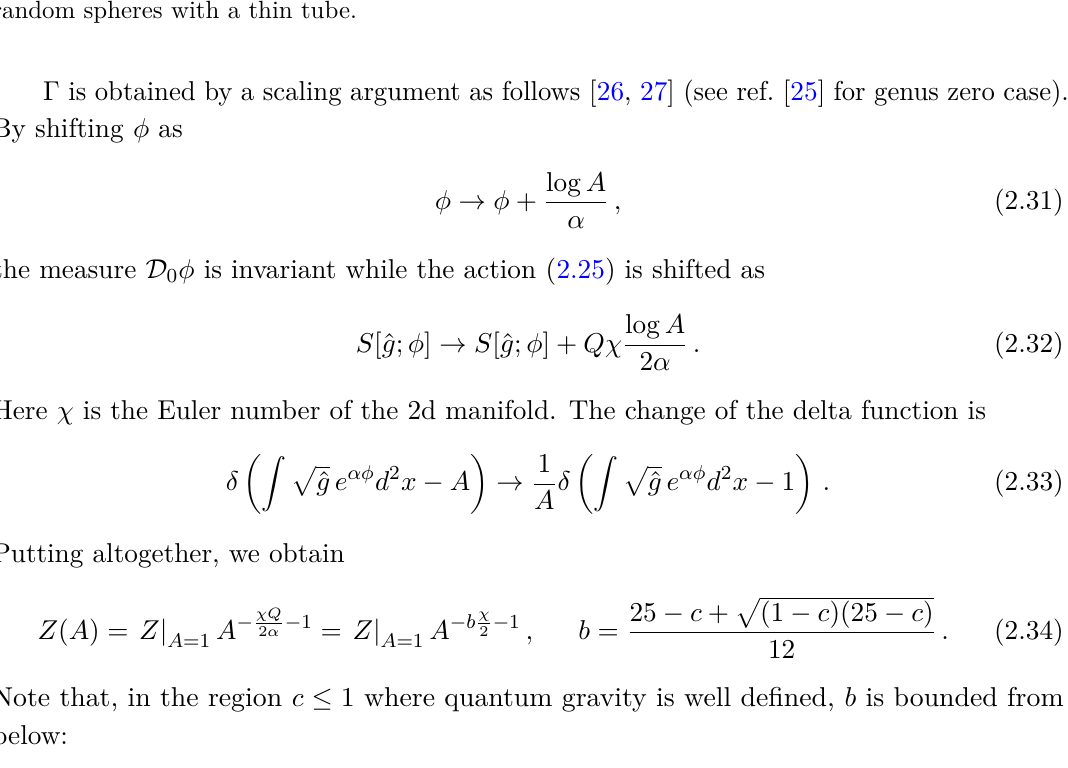
Figure 2 . For fixed large area A , the number of random tori is much larger than the number of random spheres with a thin